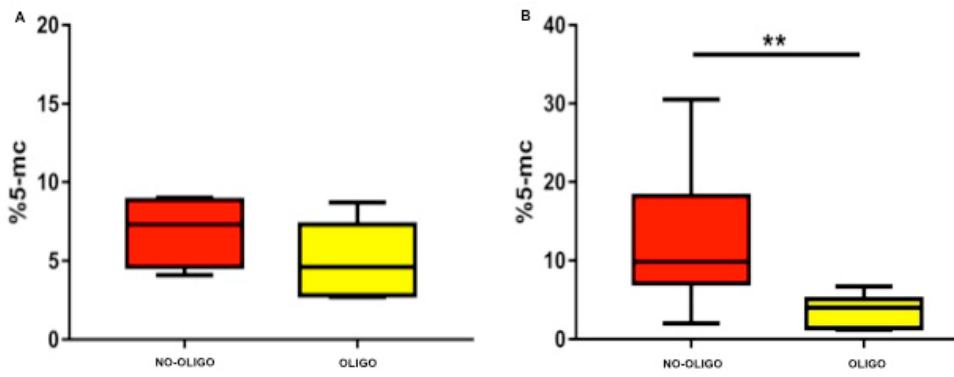
Figure 4. Histogram showing the SGDM (%5-mc) in non oligozooospermic/oligozoospermic dogs, dividing the samples according to dog’s size. NO-OLIGIO: Non oligozoospermic; OLIGO: Oligo- zoospermic. Medium sized dogs ( A ) show no significant differences. Large sized dogs ( B ) show a significant difference (** p < 0.005).